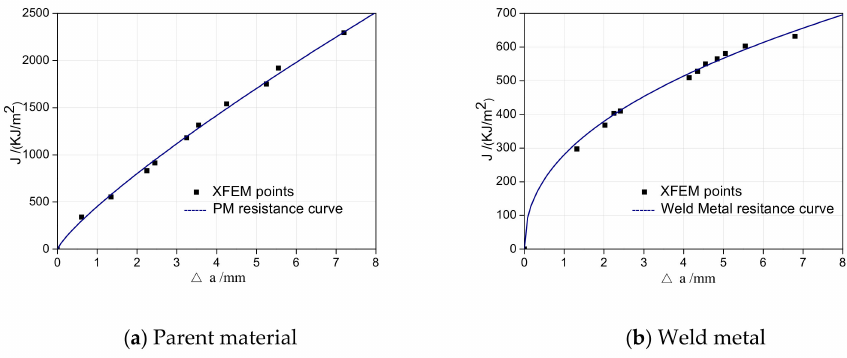
Figure 19. J integral verification of the XFEM. ( a ) Parent material; ( b ) Weld